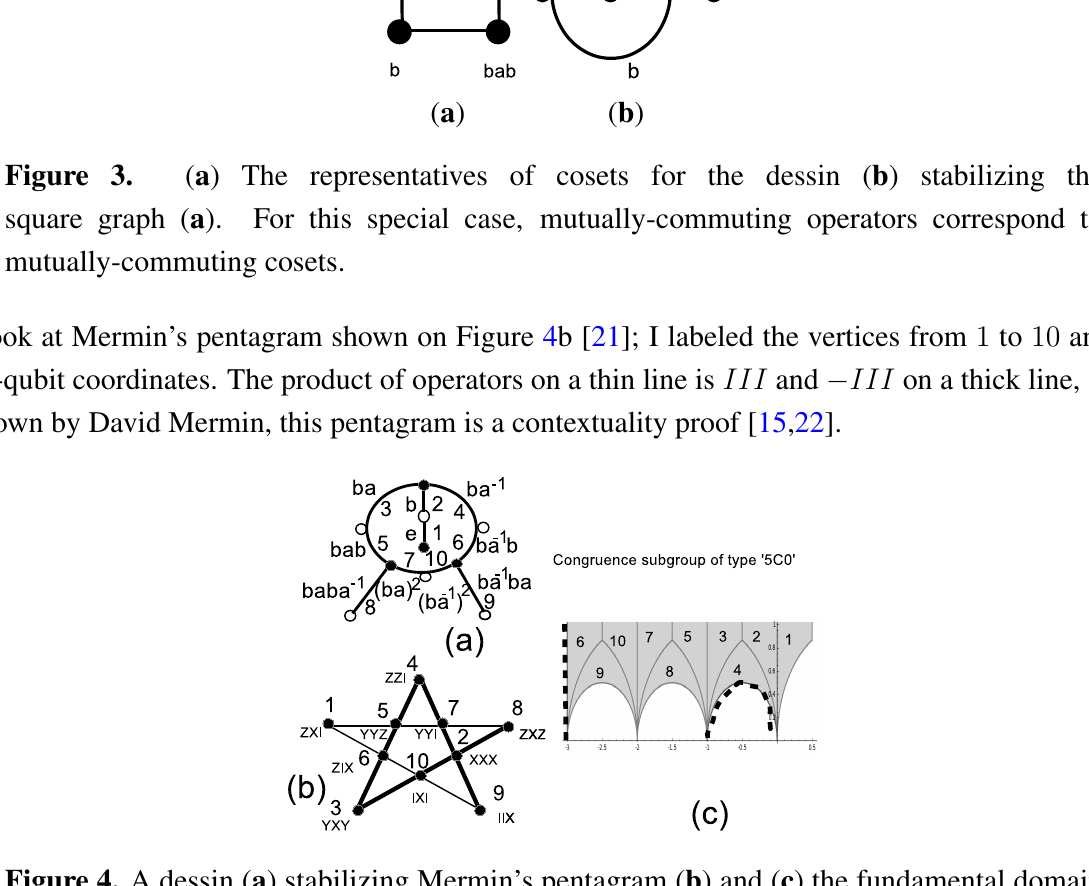
Figure 4. A dessin ( a ) stabilizing Mermin’s pentagram ( b ) and ( c ) the fundamental domain of congruence subgroup “ 5 C 0 ”. The pictures have coordinates in the G -set { 1 .. 10 } with